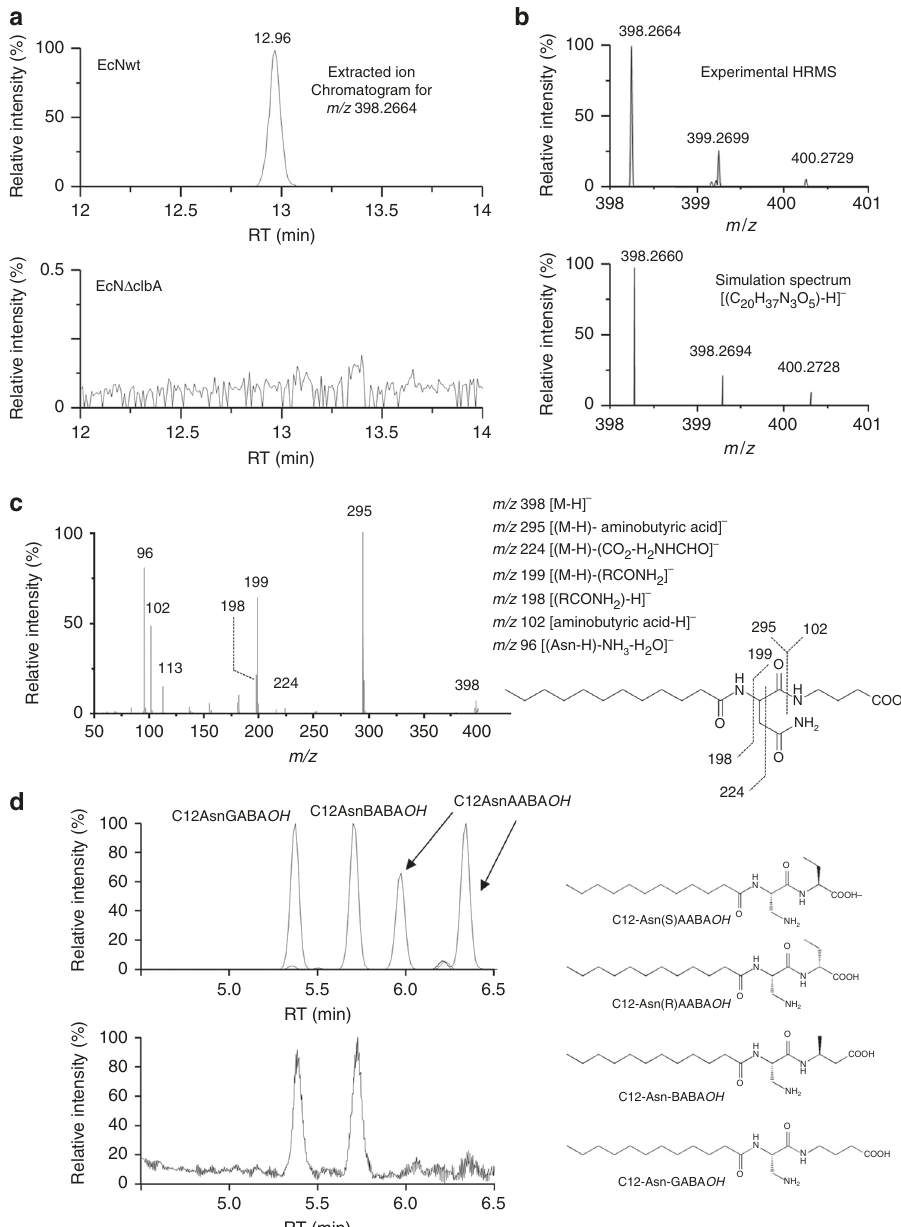
Fig. 3 Characterization of C12-Asparagine-aminobutyric acid by LC-HRMS. a EIC of a lipidic extract of EcNwt (up) and EcN Δ clbA pellet (down) for m / z 398.2664. No signal was detected in the mutated strain. b Natural isotopic distribution of the deprotonated molecule displayed by the high-resolution mass spectrum zoom obtained for the peak eluted 15.33 min in both TIC (top) at 12.96 min in the probiotic strain EIC (top) and natural isotopic pattern calculated with the formula [(C 20 H 37 N 3 O 5 )-H] − . Analogous natural isotopic patterns and similar m / z ratios measured and simulated for the monoisotopic [( 12 C 20 1 H 37 14 N 3 16 O 5 )-H] − ion and for the [( 13 C n C 20-n 1 H 37 14 N 3 16 O 5 )-H] − ] − (with n = 1 and 2) ions (within an accuracy of 1.8 ppm). Same isotopic pro fi le and a mass accuracy of 1.8 ppm were obtained. c Product ion spectrum acquired via HCD (NCE = 35%) of the carboxylate anion [M-H] − ( m / z 398) generated in electrospray from the LC peak eluted at 12.96 min. d Upper panel: chromatogram obtained for the four synthesized standards: C12-Asn- γ - aminobutyric acid (C12Asn-GABA OH ), C12Asn-( S )AABA OH and C12Asn-( R )AABA OH , C12-Asn- α -aminobutyric acid (C12Asn-BABA OH ) and C12-Asn- α - aminobutyric acid (C12Asn-AABA OH ) (two diastereoisomers are detected which present similar HCD spectrum with NCE = 35%); lower panel: Chromatogram obtained for the lipid extract of EcNwt